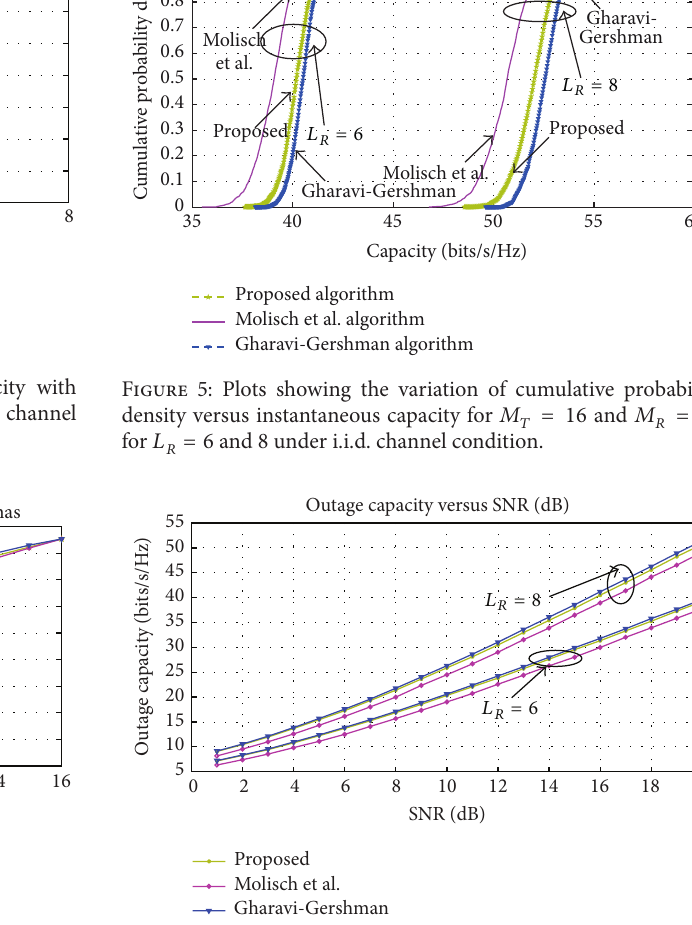
Figure 4: Plots showing the variation of outage capacity with number of selected antennas for 𝑀 𝑇 = 16 and 𝑀 𝑅 = 16 under i.i.d. channel condition.